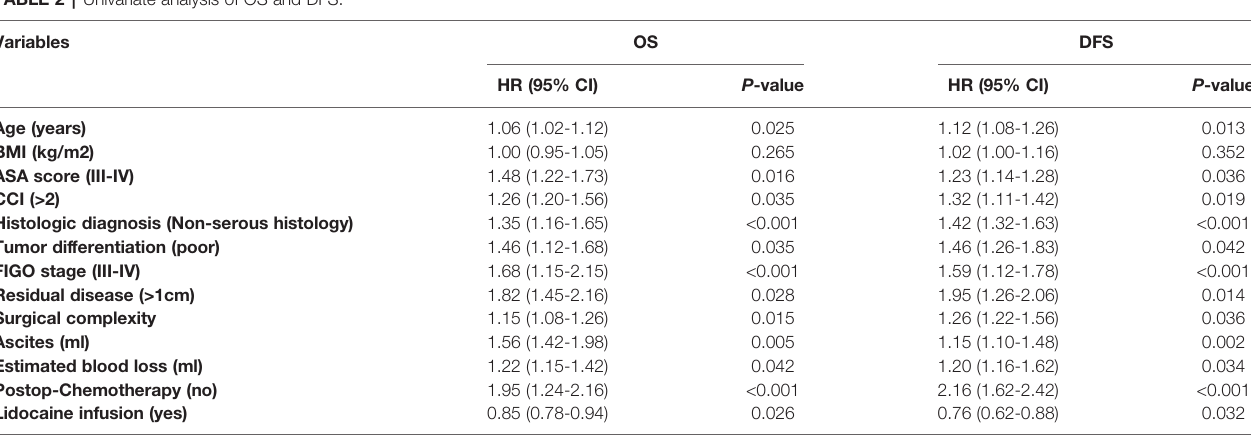
BMI, Body Mass Index; ASA, American Society of Anesthesiologists score; CCI, Charlson Comorbidity Index; FIGO, Federation International of Gynecology and Obstetrics OS, Overall Survival; DFS, Disease free